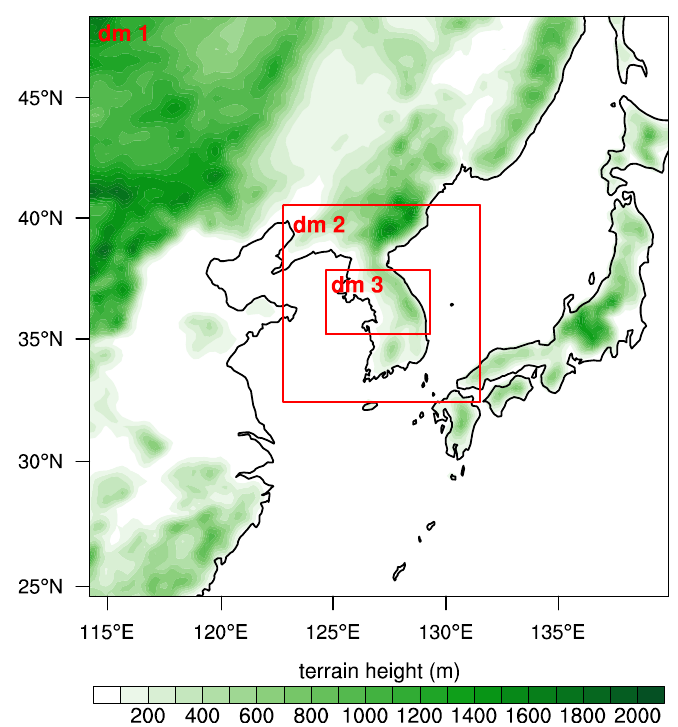
Table 2. Horizontal grid size, number of horizontal grid points, and time step in each computational domain.